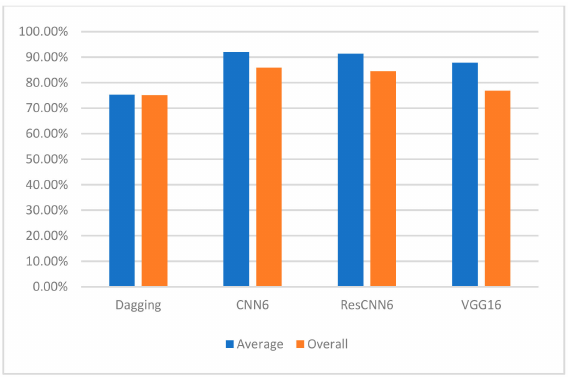
Figure 5. Comparison of the average and overall accuracies of the di ff erent classifiers.